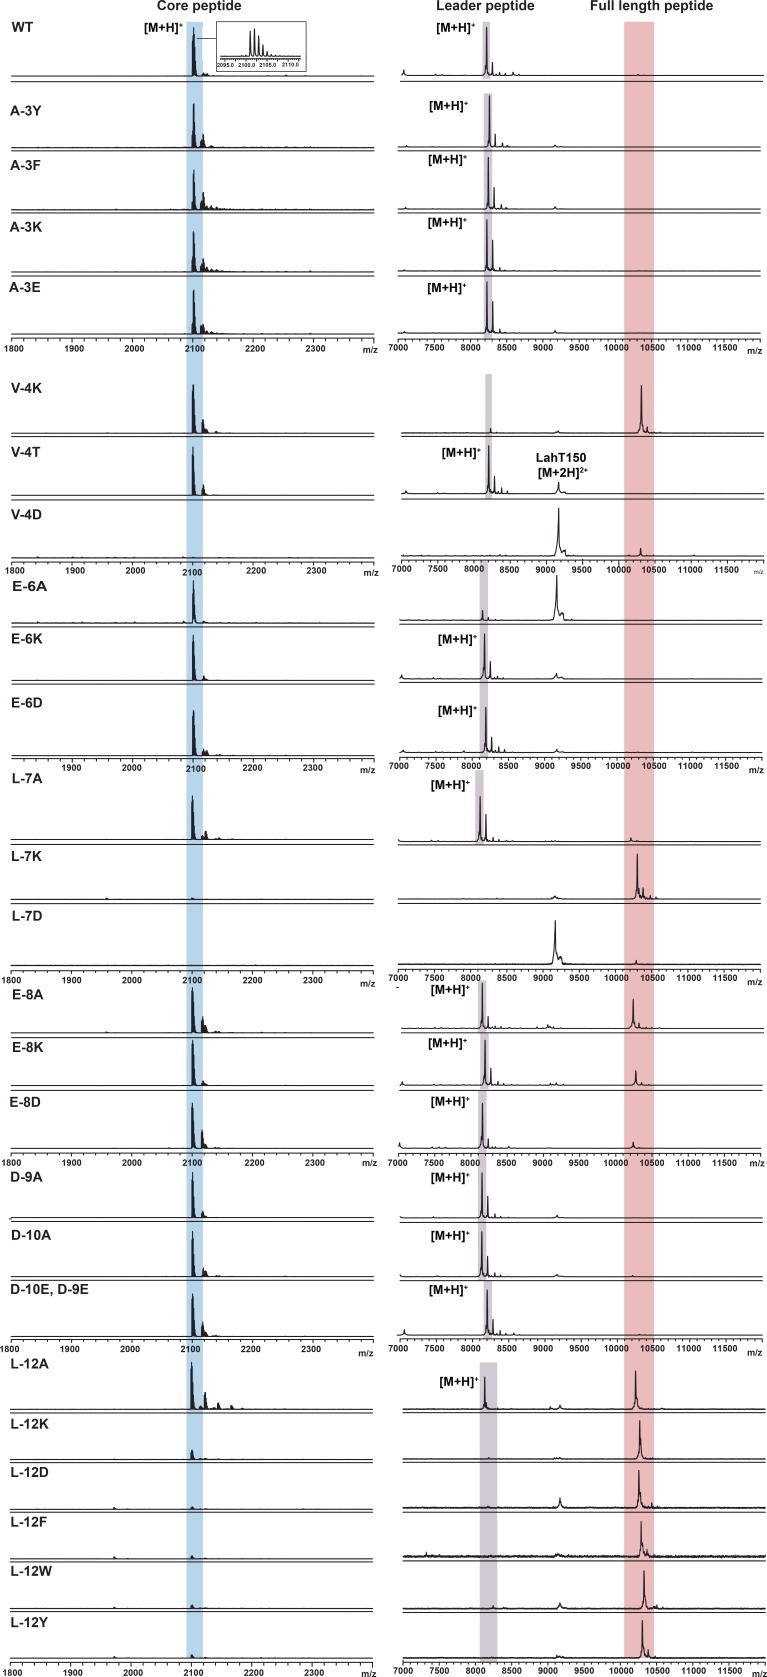
Assessment of the importance of individual amino acids in the leader peptide for LahT150 catalysis.LahT150 catalyzed cleavage reactions of XY33a wild-type and leader peptide mutants. XY33a-core peptide mass [M + H]+ theor 2100.0; obs 2100.9–2101.1 in all spectra.